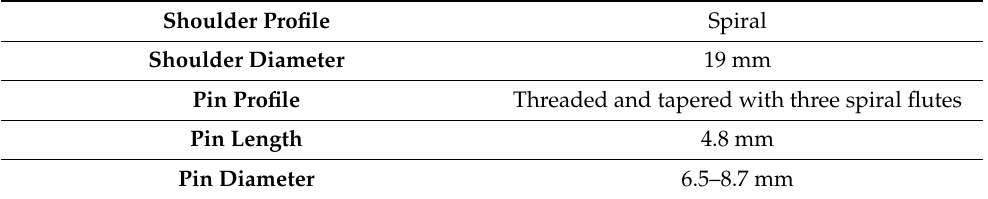
Table 4. The dimensions of the used tool.